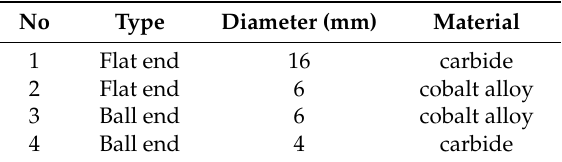
Table 1. Characteristics of the cutting tools employed in the present